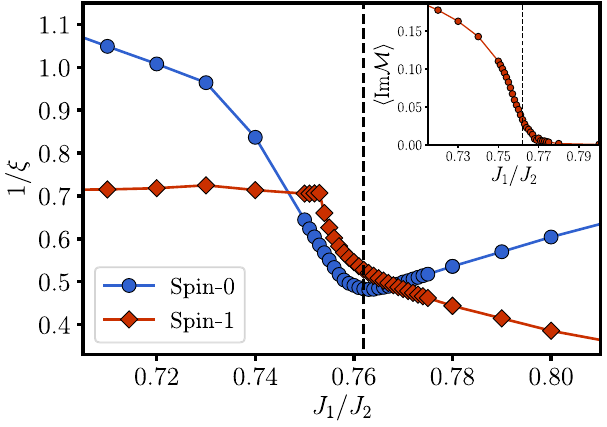
FIG. 4. The inverse of the largest correlation length for spin- singlet and -triplet operators as a function of J 1 =J 2 at L ¼ 10 and χ ¼ 4000 . Here, the dashed line represents the transition point extracted from the second-order energy derivative. The small plot at the top right shows the plaquette order parameter (Im M ) across the transition. Deep in the VBS phase, the correlation length of a spin-triplet operator is larger than that of a spin-singlet operator as expected by a mean-field theory. As we approach the critical point, we can observe that the correlation length of the spin-singlet sector becomes larger than that of the spin-triplet sector. This behavior agrees with what is expected from the scenario in Fig. 8.